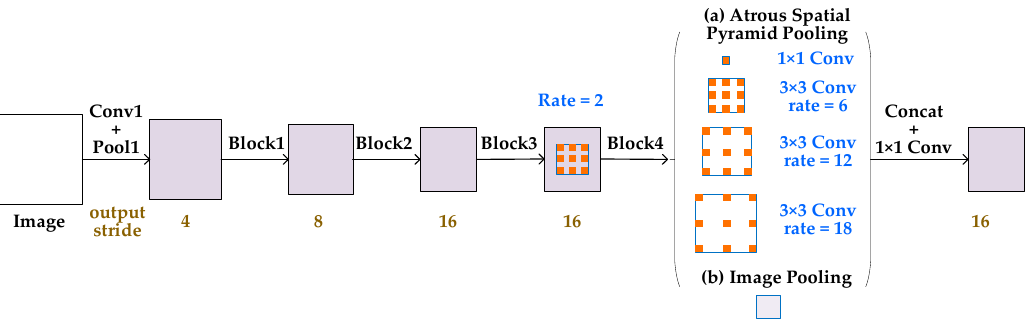
Figure 2. Overview of DeepLab v3 architecture consisting of three stages: basic network, Atrous Spatial Pyramid Pooling (ASPP) module and post-processing stage [28].